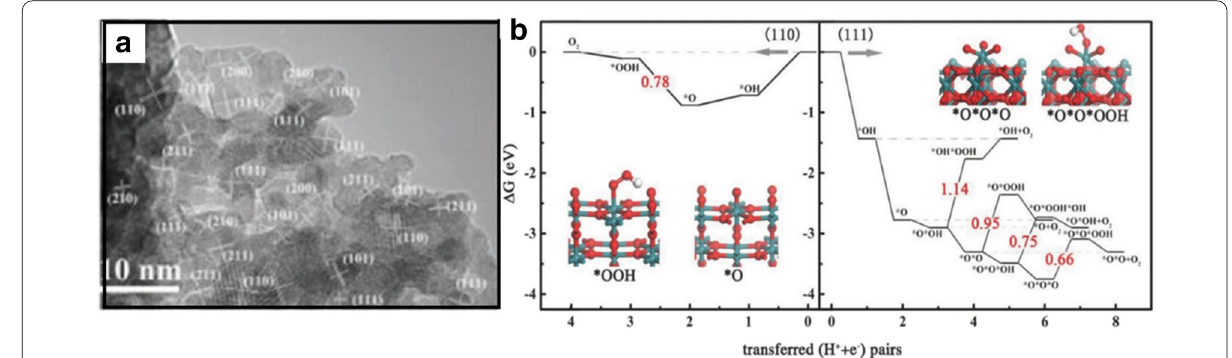
Fig. 10 a High‑resolution TEM (HRTEM) of Cu‑doped RuO 2 with high‑index surface facets being indicated. b Free energy profile of OER on (110) and (111) surfaces (Figure reprinted with permission from Ref.